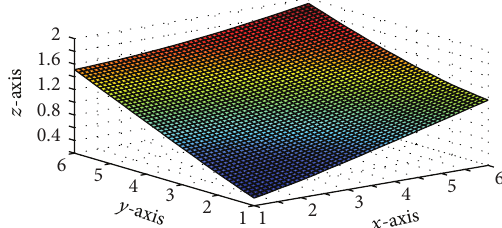
Figure 6: 𝐶 1 monotone rational trigonometric bicubic function with 𝛼 𝑖,𝑗 = 12 , 𝛿 𝑖,𝑗 = 12 , 𝛼 𝑖,𝑗+1 = 14 , 𝛿 𝑖,𝑗+1 = 13 , ̂𝛼 𝑖,𝑗 = 12 , 12 , ̂𝛼 = 15 , ̂𝛿 = 13 . 𝑖+1,𝑗 𝑖+1,𝑗